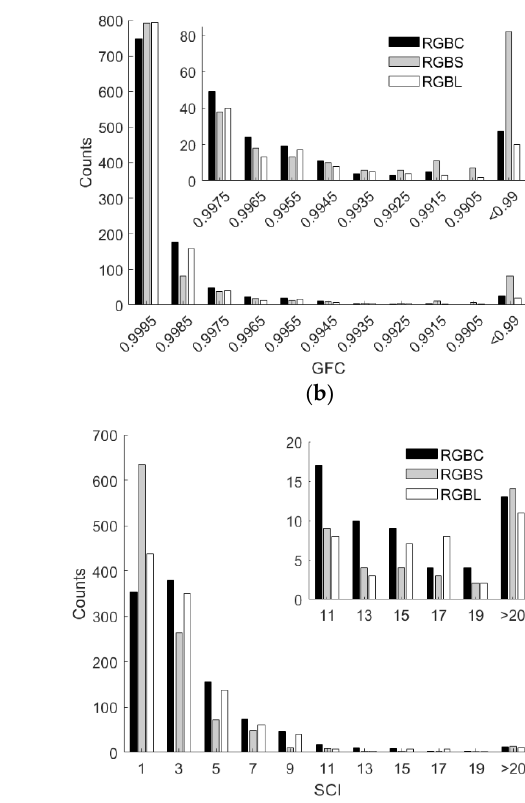
Figure 11. ( a ) E Ref , ( b ) GFC, ( c ) Δ E 00 and ( d ) SCI histograms for the 1066 test samples. The cameras are the optimized RGBC, RGBS and RGBL cameras. Spectra are reconstructed using the LUT method. The insets in ( a – d ) show enlarged parts.